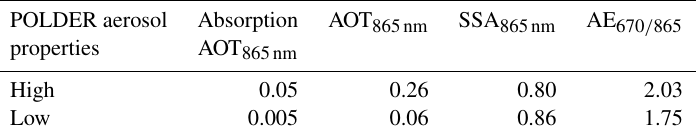
Table 2. Mean values of aerosol properties over the specific area from June to August 2008, in the case of high values of absorption AOT (>0.04) and in the case of low values of absorption AOT (<0.01),